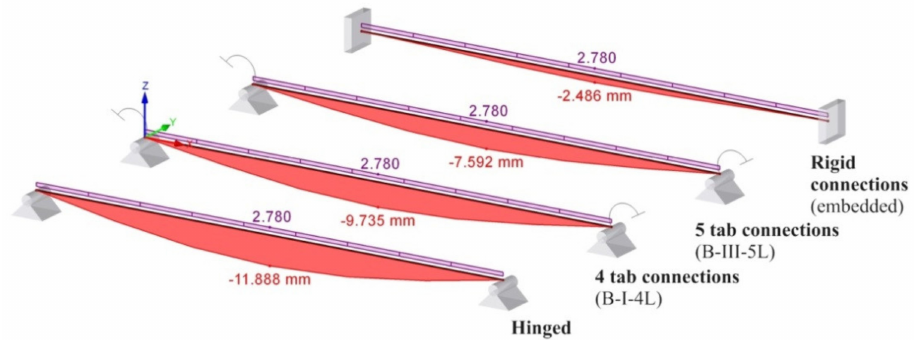
Figure 21. Comparison of the bending moment diagrams for di ff erent boundary conditions in case of the type B beam.